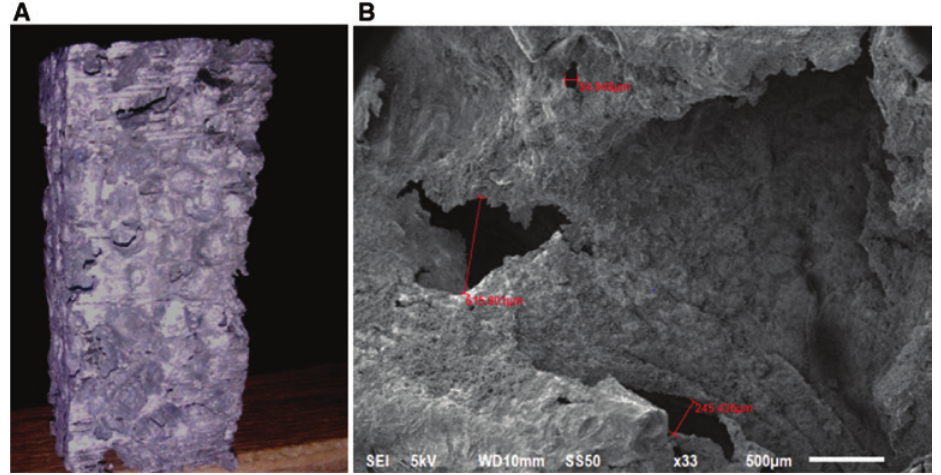
Figure 1: Foam-0 (A) Cross-sectional image (B) SEM